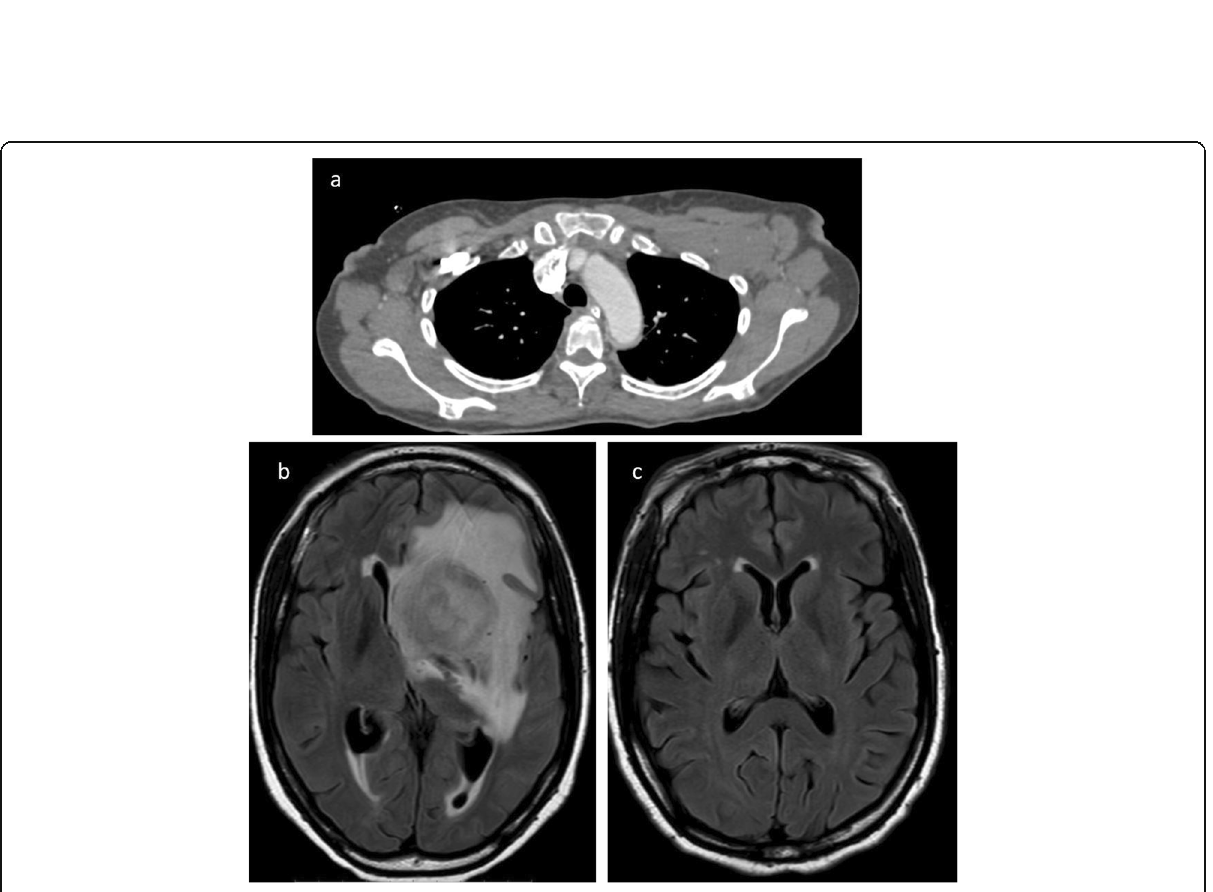
Fig. 10 Axial CT image ( a ) demonstrates bilateral axillary lymphadenopathy, proven to be DLBCL after biopsy. The patient successfully completed treatment but developed CNS symptoms 1 year later. MRI of the brain ( b ) showed a large heterogenous mass in the left cerebral hemisphere which biopsy was proven to be lymphoma. A previous MRI brain ( c ) was negative for CNS